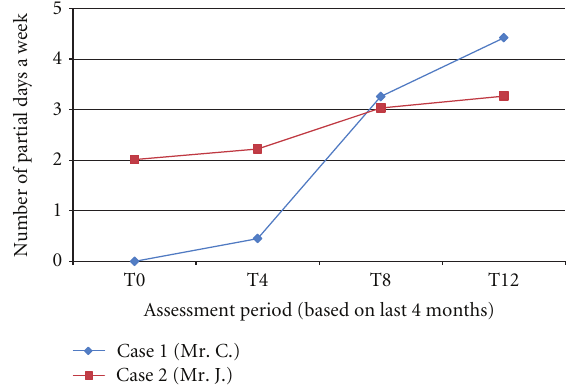
Figure 1: Participation in work-related activities for the two